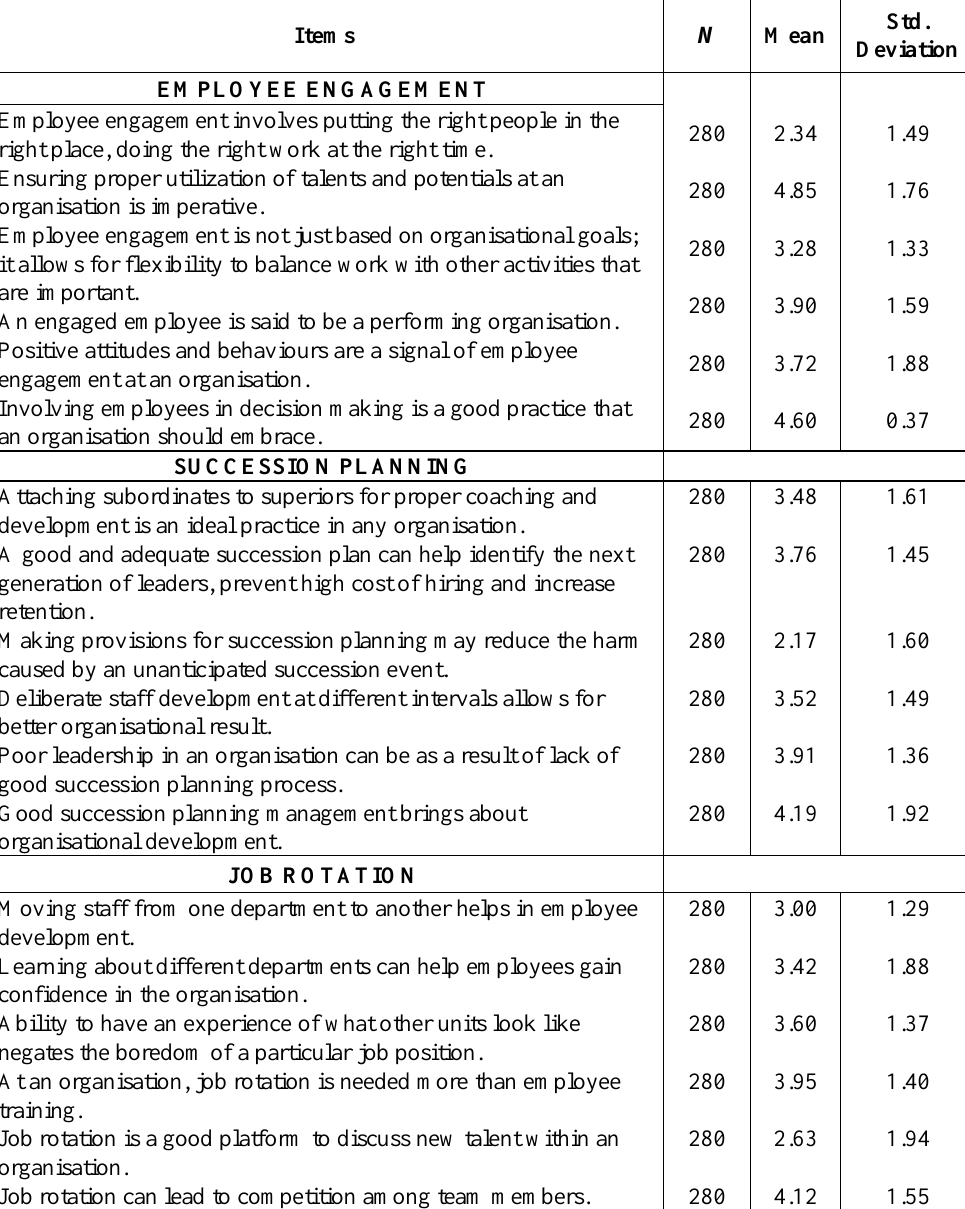
Table 2. Descriptive Statistics of Skill Mapping, Talent Pool